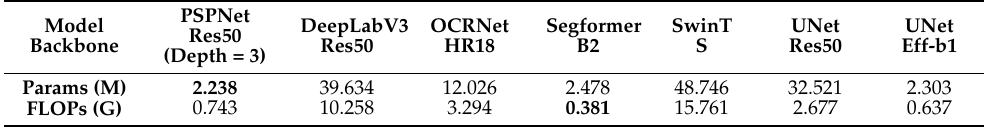
Table 5. Efficiency levels of different semantic segmentation